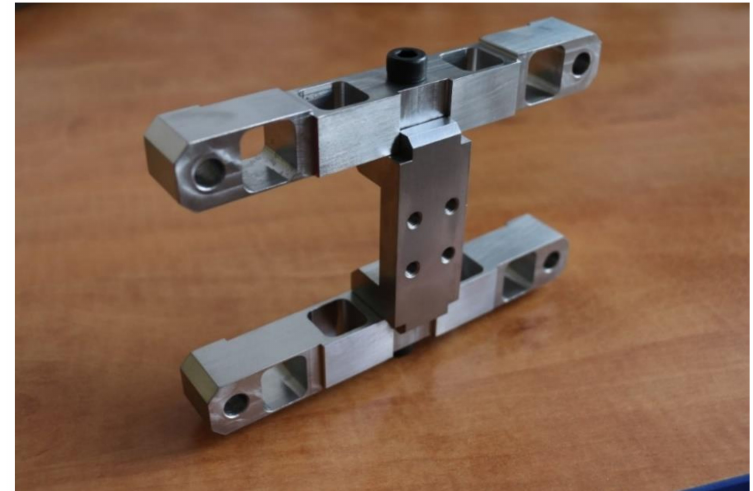
Figure 13. Actual force transducer